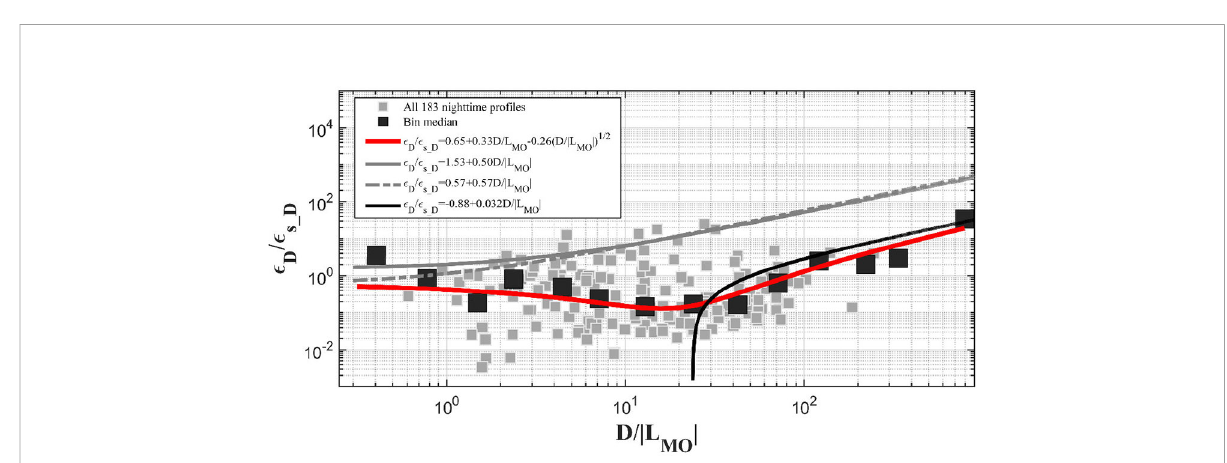
FIGURE 4 ϵ D D fi les (gray squares). The black squares denote the median values of 14 bins for all nighttime pro fi les, and ϵ s _ D versus j L MO j for all nighttime pro they are fi tted with Eqs. (15) and (17) as shown by the black and red solid lines, respectively. The gray line and gray dashed line denote the Eqs. (12) and (13),